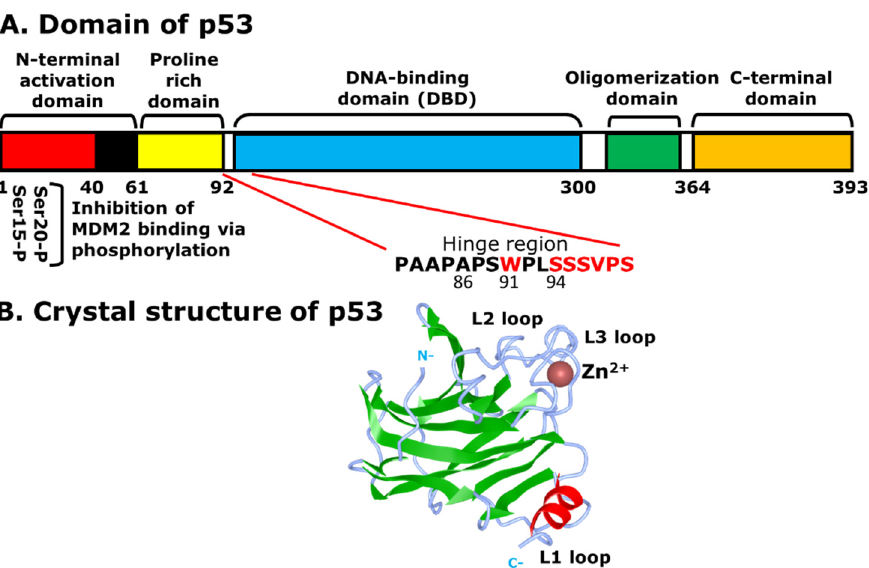
Figure 1. Structural features of p53: ( A ) different domains of p53. The Ser-15 and Ser-20 of the N-terminal activation domain (1–61), or TAD1 and TAD2, undergo phosphorylation and are the specific sites for interaction with MDM2 for ubiquitination and degradation of p53, although Mdm2 can bind to other domains, such as the C-terminal domain. Other domains include the proline rich domain (64–92), the DNA-binding domain (DBD) (100–300), the oligomerization domain